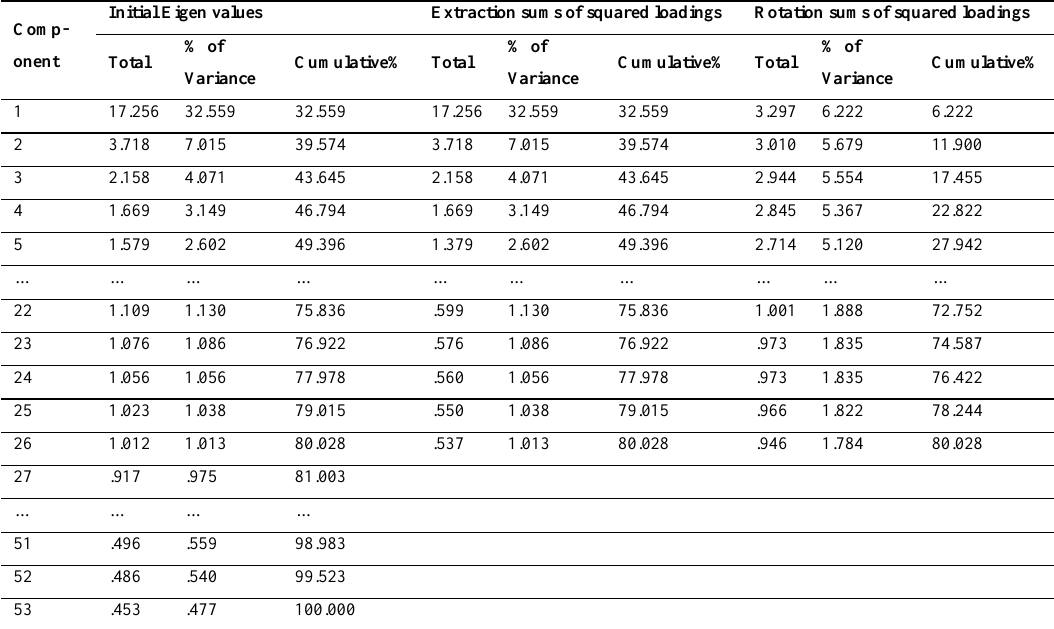
Table 2 Total variance table of factors influencing creativity